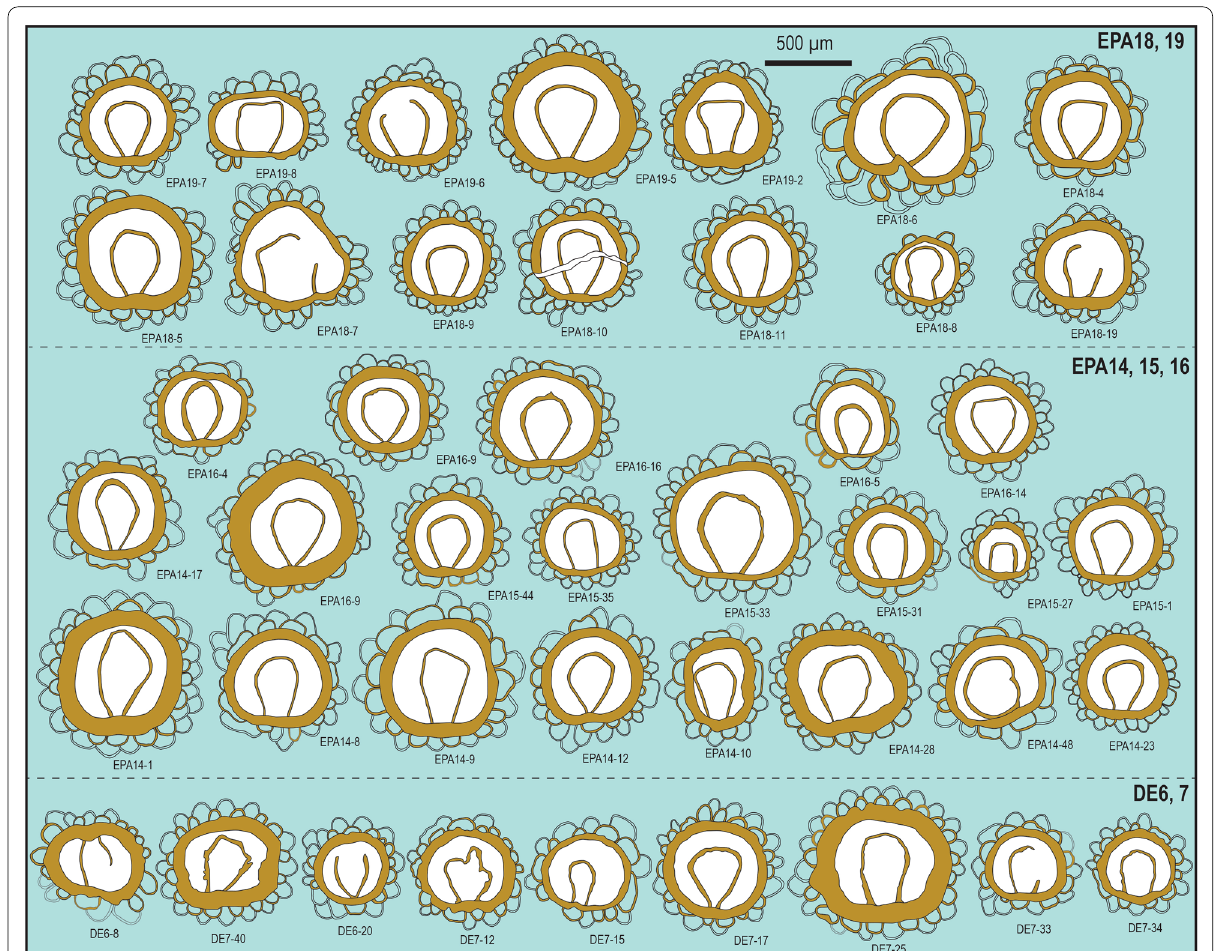
Fig. 15 Line drawings of the embryonic–nepionic stages of O. ex. interc. gruenbachensis Papp– apiculatus Schlumberger from the Taraklı